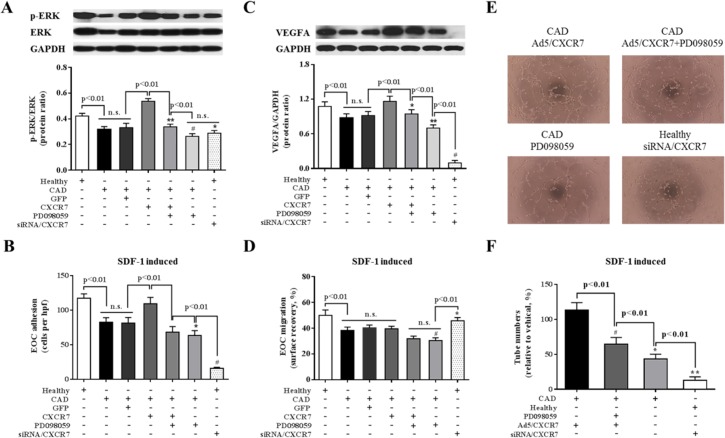
CXCR7/ERK signaling influences angiogenesis and VEGFA expression of EOCs.CXCR7/p-ERK signaling is involved in the reduced functions of CAD-EOCs. A: Representative photographs and quantitative analyses of p-ERK protein expression in EOCs at 48 hours after treatments (**P<0.01, #P<0.01 vs. Ad5/CXCR7-CAD EOCs; *P<0.01 vs. healthy EOCs and Ad5/CXCR7-CAD EOCs; n = 5 per group). B: Representatively quantitative analyses of the adhesion activity of EOCs with SDF-1 (*P<0.01 vs. CAD-EOCs; #P<0.01vs. healthy EOCs or Ad5/CXCR7-CAD EOCs; n = 5 per group). C: Representative photographs and quantitative analyses of VEGFA protein expression in EOCs at 48 hours after treatments (*P>0.01 vs. CAD-EOCs;**P<0.01 vs. Ad5/CXCR7-CAD EOCs and CAD-EOCs; #P<0.01 vs. healthy EOCs and Ad5/CXCR7-CAD; n = 5 per group). D: Representatively quantitative analyses of the migratory activity of EOCs with SDF-1 (#P<0.01vs. CAD-EOCs; *P>0.01 vs. healthy EOCs; n = 5 per group). E-F: Representative photographs (E) and quantification analyses (F) of angiogenic function in the Matrigel. (#P<0.01, *P<0.01, **P<0.01 vs. Ad/CXCR7-CAD EOCs; n = 5 per group).